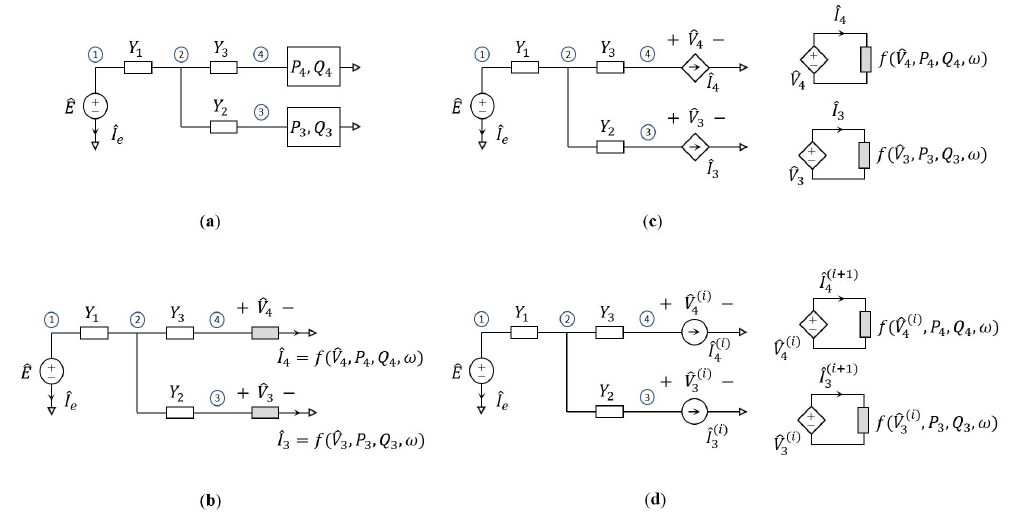
Figure 3. Circuital interpretation of a generic power distribution network; ( a ) the example adopted for the analysis, and panels ( b – d ) are transformations and interpretations of panel ( a ), as illustrated in the